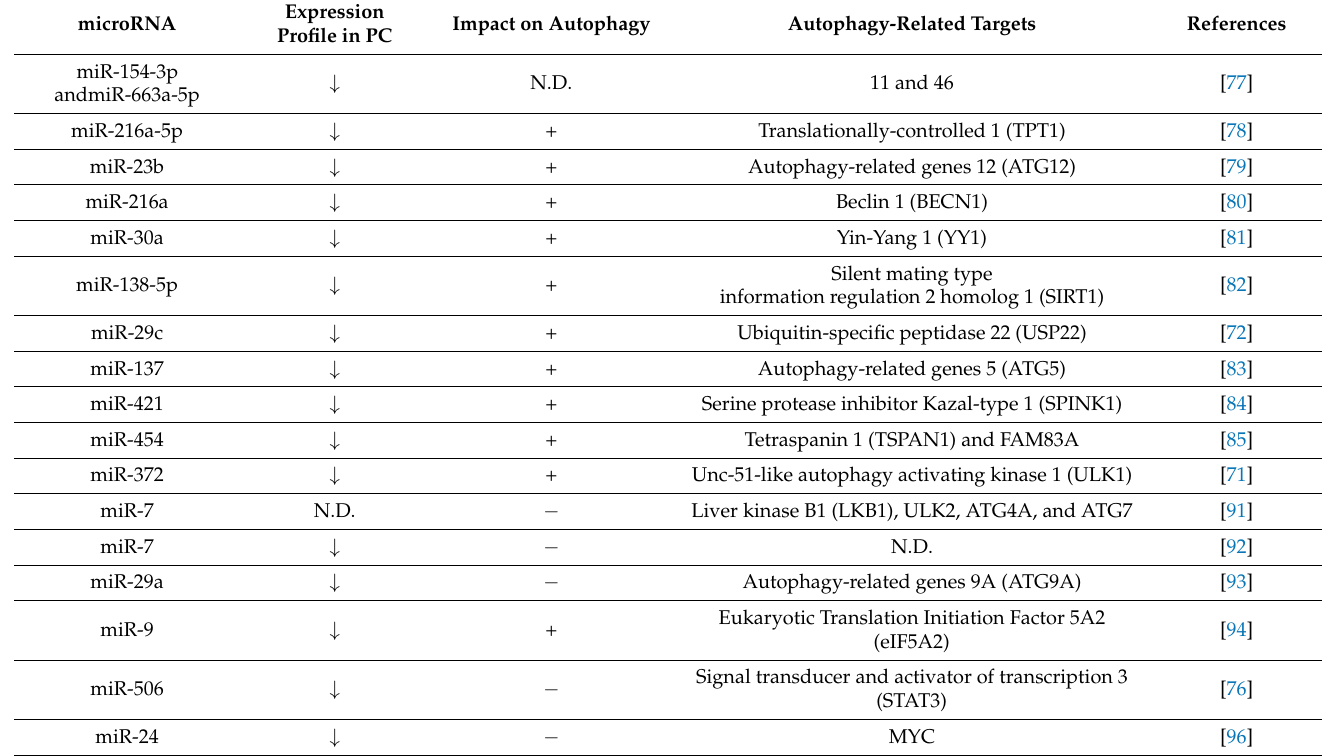
Table 1. Summary of differentially expressed autophagy-related miRNAs in